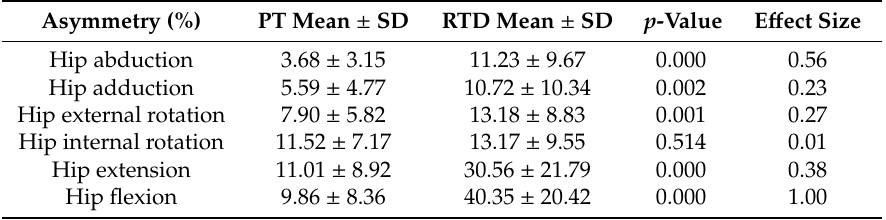
Table 3. Peak torque and Rate of torque development di ff erences (Mann–Whitney U